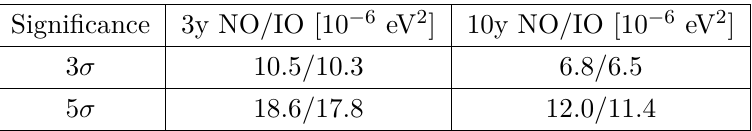
Figure 6. Discovery potential for 3 (red) and 10 (blue) years of data taking in KM3NeT/ORCA assuming NO (solid lines) and IO (dashed lines) as a function of the true α 3 in the Asimov dataset. The vertical lines are the 90 % CL limit α 3 values of current experiments reported in table 5. From left to right: SK+K2K+MINOS, T2K+MINOS and T2K+NO ν A.